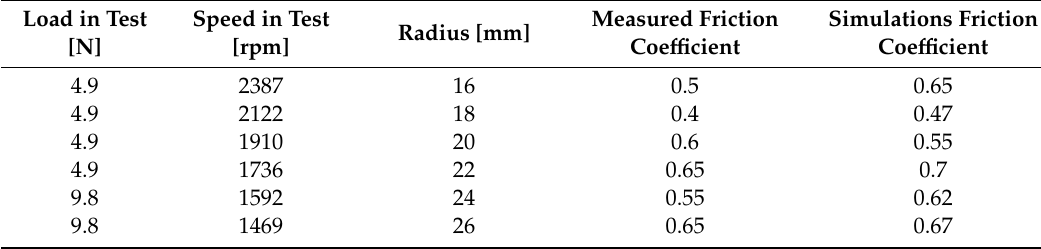
Table 4. Pin-on-disc friction coe ffi cient measurements.